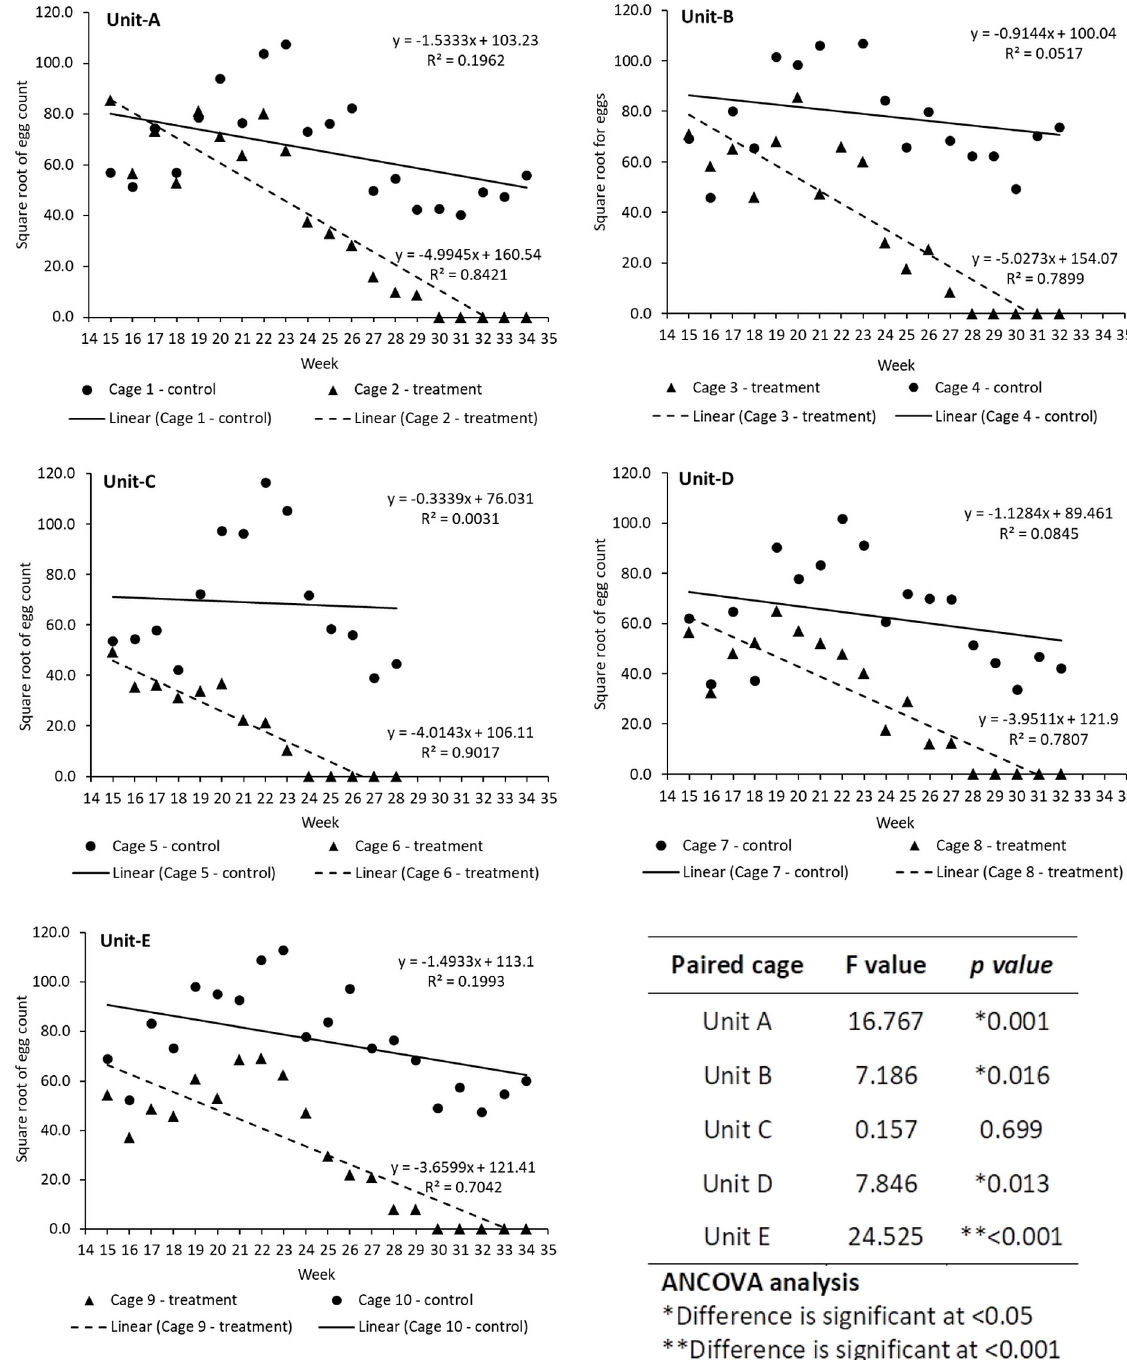
Fig 4. Egg production of Ae. aegypti AWD strain mosquito in paired cage (control versus treatment) units (A-E) during suppression period (OX513A male adult releases in treatment cages) from week 15 and ANCOVA analysis. both the total number of males and females captured was significantly (p < 0.05) different between the paired control and treated cages (except for Unit B which narrowly missed the sig- nificance threshold–p = 0.06) (S8 Table).